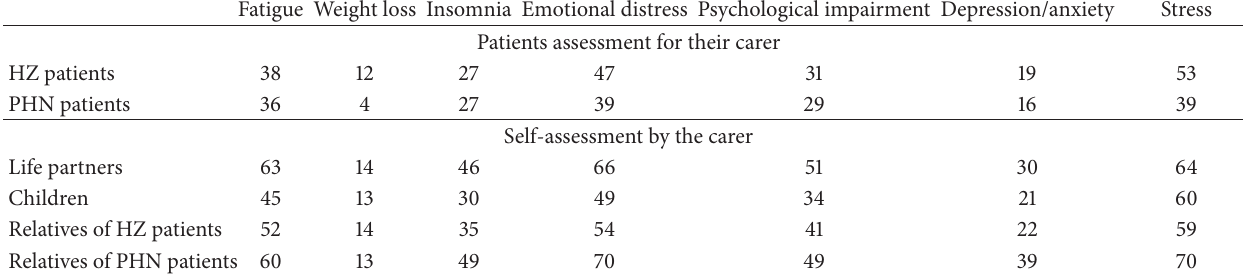
Table 3: Percentage of respondents who replied ≥ 4 (on a scale of 0 (none) to 10 (high)) to questions about the impact of the disease on the different aspects indicated. The former patients gave their assessment of the impact for their carer; the carers gave their self-assessment. Question asked: Caring for or supporting another person that is ill may have an impact on your own health. On a scale from 1 to 10, 1 meaning “does not apply at all” and 10 meaning “applies fully”, tell me to what extent the following areas were impacted when took care of or were supporting your (life-time partner/parent) during their